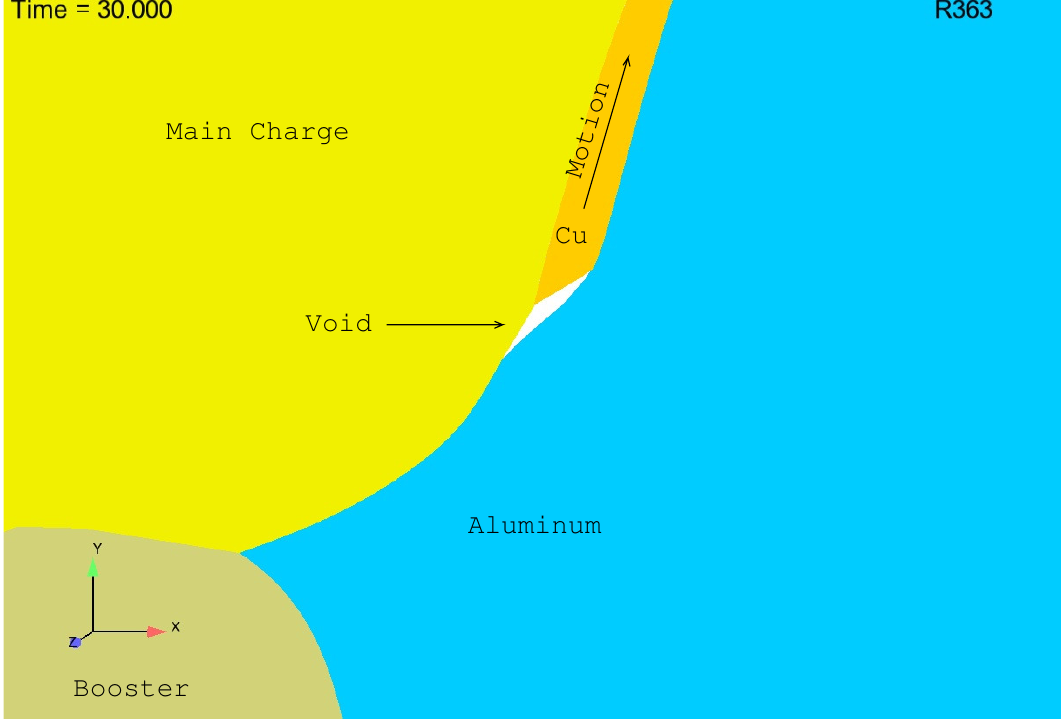
Figure 3. Larger “void” at 30 µ